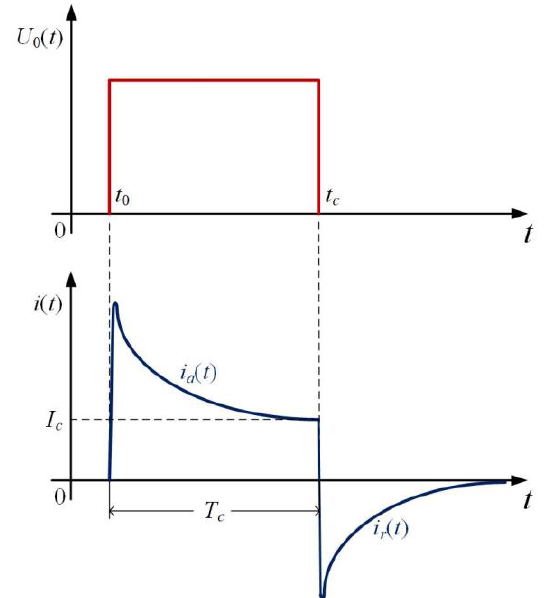
Figure 3. Time variation of the absorption i a (t) and the resorption i r (t) currents .